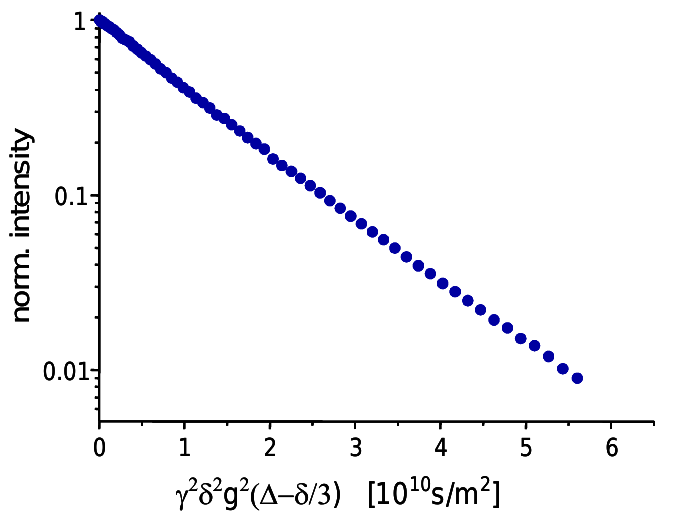
Figure 2. Stejskal-Tanner plot [4] of signal decay for PAMAM G2 at pH 5.